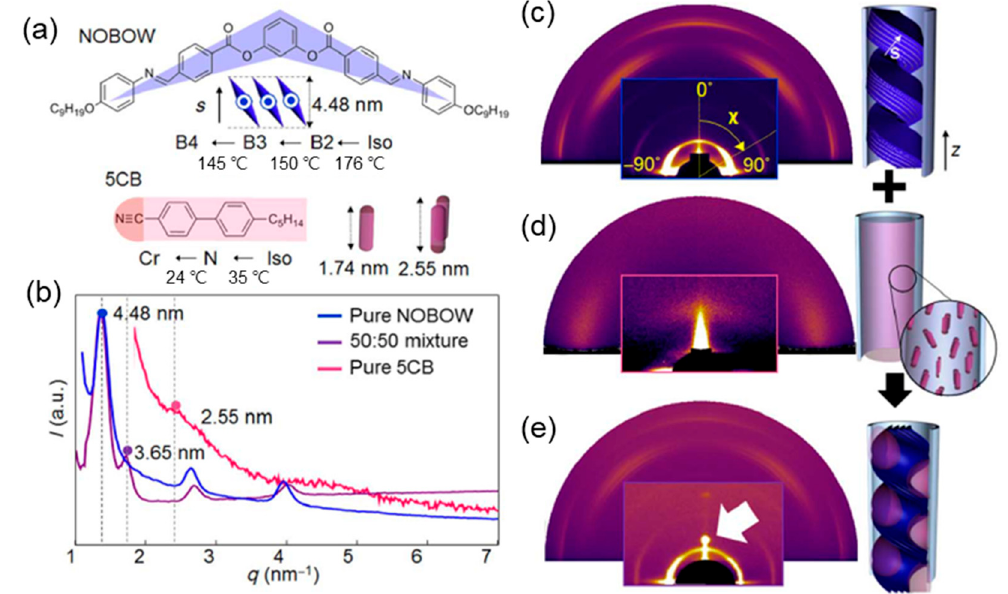
Figure 14. ( a ) Chemical structures of NOBOW and 5CB, which can form HNF and nematic phases. ( b ) 1D-XRD results of pure NOBOW (blue), pure 5CB (red), and the mixture of both molecules (purple). ( c ‒ e ) 2D-GIXD results of pure NOBOW, pure 5CB, and their mixture. ( e ) The mixture shows